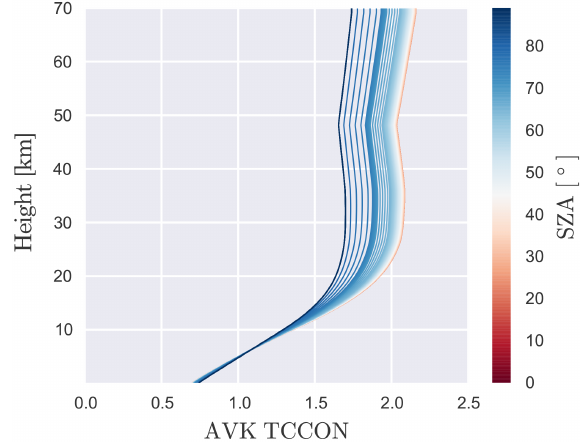
Figure 11. Column averaging kernels (mean of kernels from both NIR spectral windows) for the TCCON retrieval for different solar zenith angles (SZAs). Intermediate kernels are obtained from lin- early interpolated averaging kernels from one Karlsruhe measure- ment day covering a wide range of SZA.